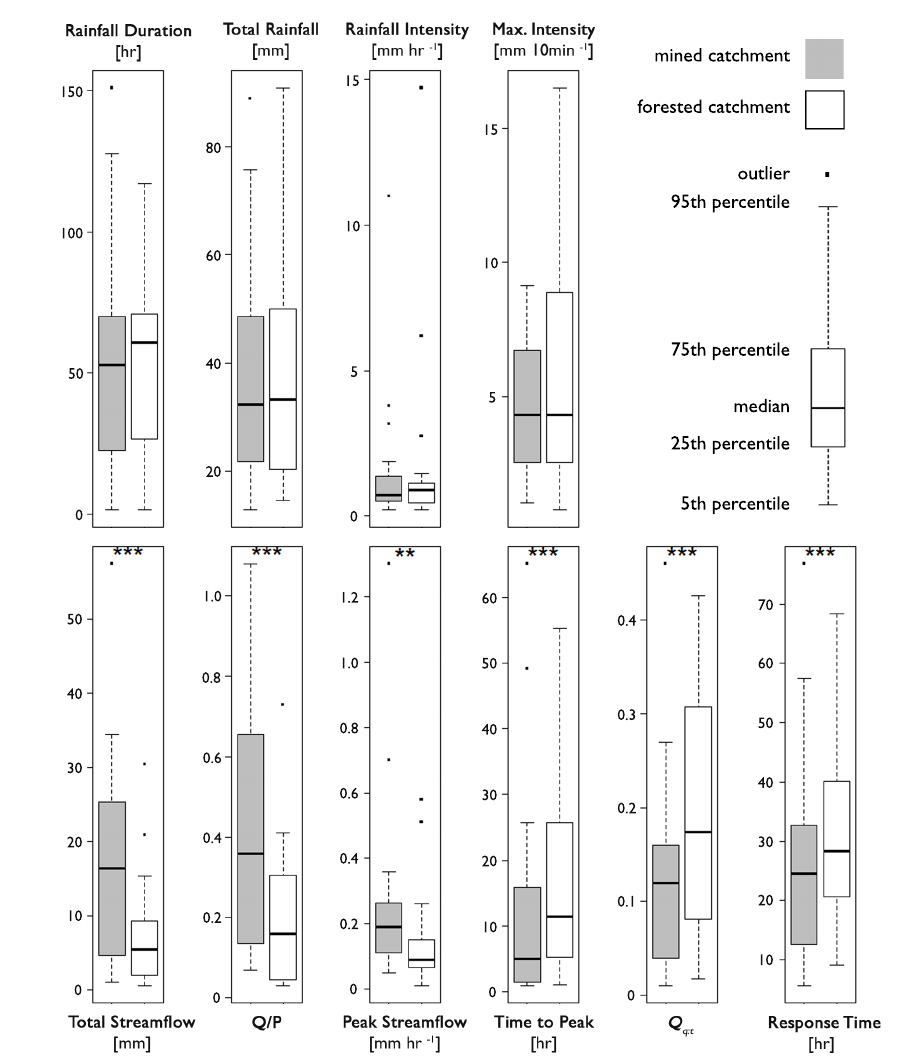
Figure 6. Event rainfall and runoff boxplots for the mined and forested catchments over 23 storm events that occurred during September 2011–October 2012. *** and ** indicate statistically-significant differences at the 99% and 95% confidence level based on the Wilcoxon signed rank